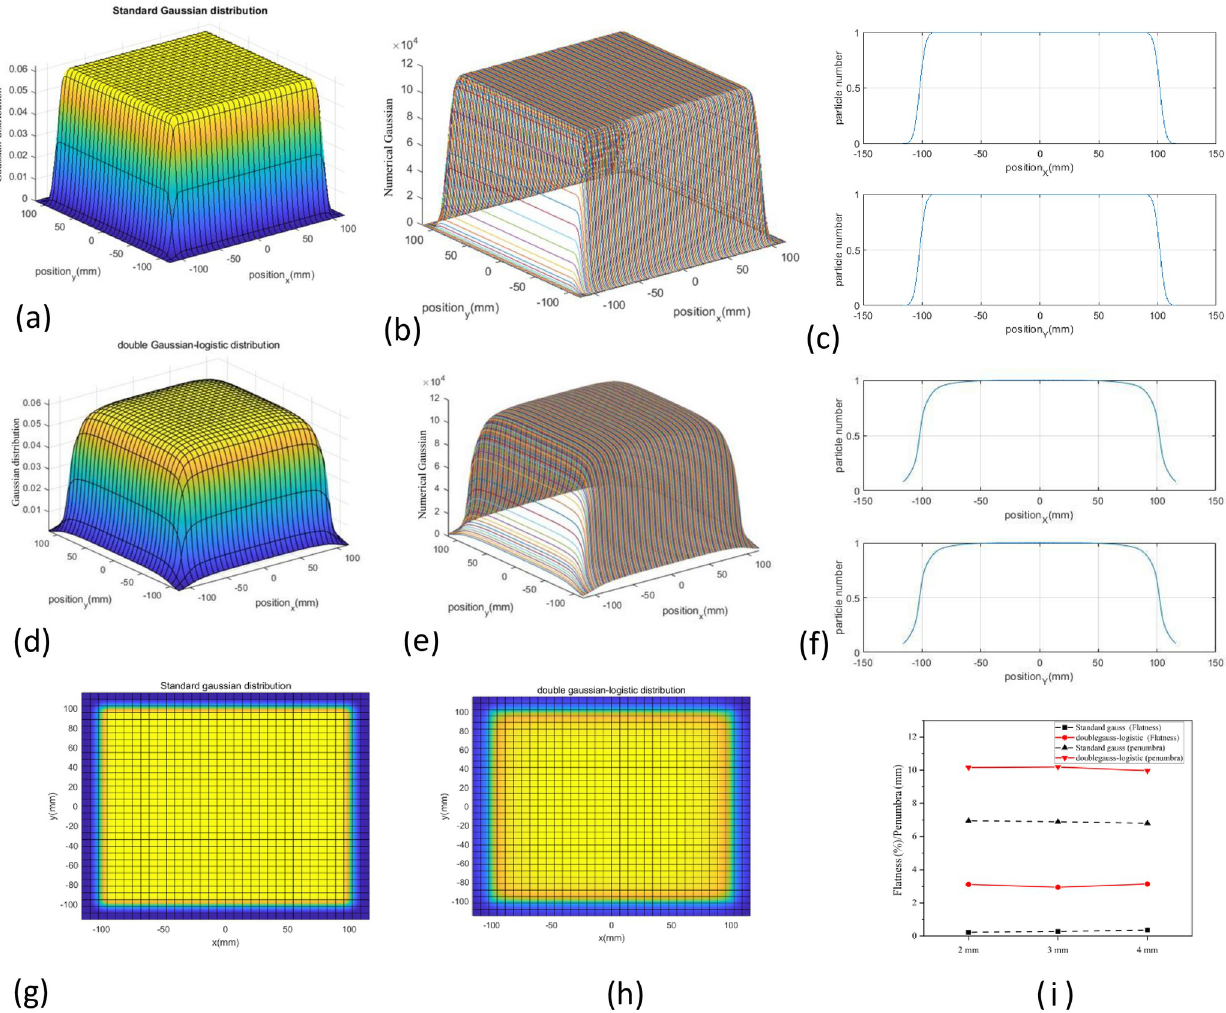
Fig 5. Superimposed field of PB. (a) 3D standard Gaussian distribution and (d) the double Gaussian-logistic distribution was plotted in MATLAB. (b) and (c) The projection of Gaussian distribution was drawn in both x- and y-directions. (e) and (f) The projection of double Gaussian-logistic distribution was drawn in both x- and y-directions. (g) The flat plane for standard Gaussian distribution is plotted. (h) The flat plane for double gaussian-logistic distribution is plotted. (i) The calculated flatness and penumbra were compared in the standard Gaussian model and the double Gaussian-logistic model.